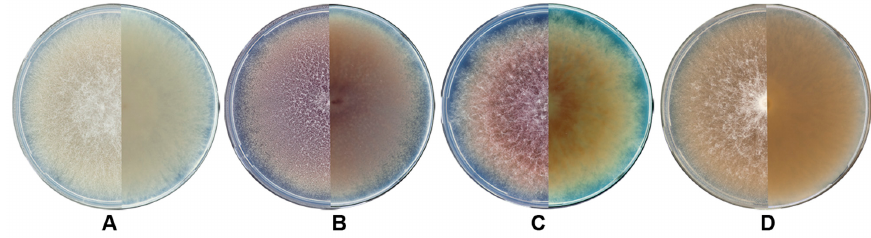
Figure 2. The colony phenotypes of F. langsethiae from above (the left part) and in reverse (the right part) on potato-sucrose agar (PSA) after incubation at 24 ◦ C for seven days in darkness: ( A ) colorless, ( B ) violet, ( C ) pale red, ( D ) peach.